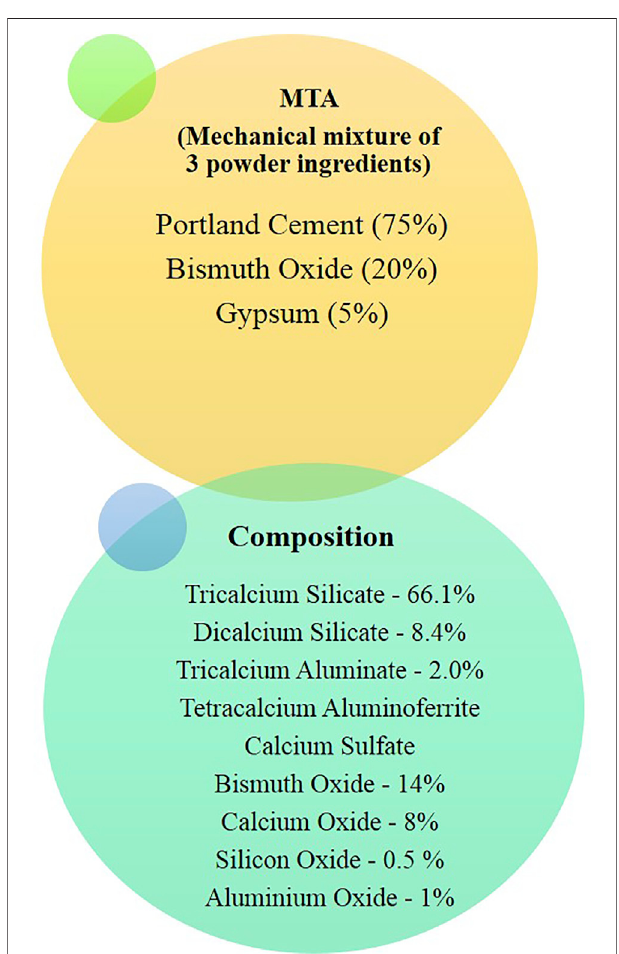
FIGURE 2 | Composition of modi fi ed